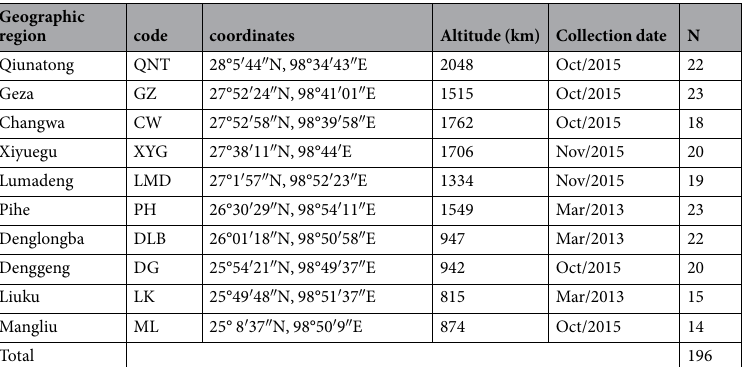
Table 1. Sample collection data of Nujiang populations of Creteuchiloglanis macropterus . The N is represented number of individuals sampled per locality, and the code is abbreviation of the geographic region.